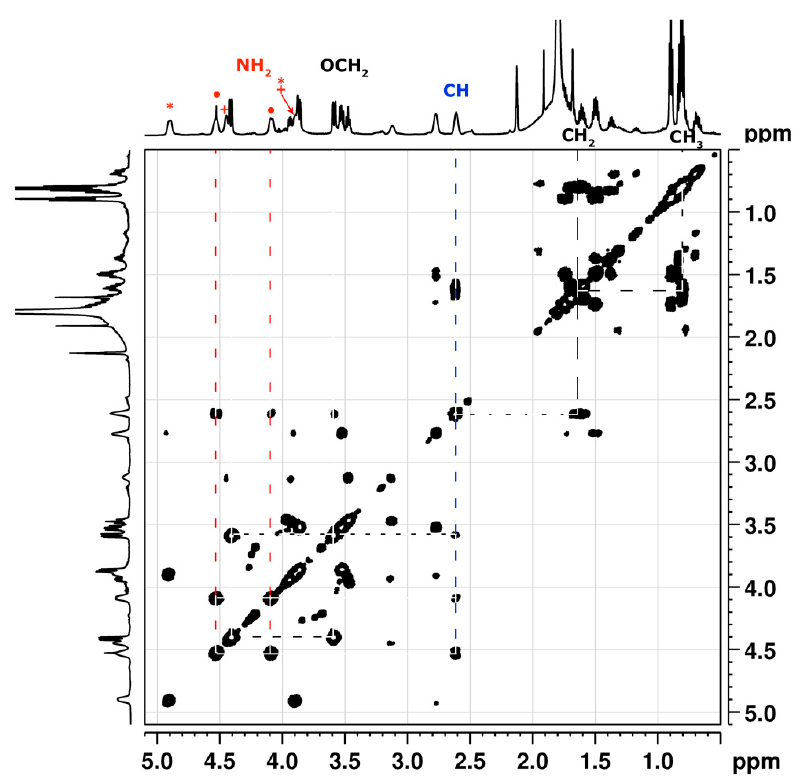
Figure 4. 1 H- 13 C HSQC NMR spectrum of 2 M mixture of ligand 2c and BH 3 •SMe 2 in toluene-d 8 . The correlation peaks originating from the three sets of 2-aminobutanol-based structural fragments are indicated as follows: ( a ) the OCH 2 groups (blue dots) and the CH(NH 2 ) groups (black dots), and ( b ) the CH 2 groups (blue dots) and CH 3 groups enclosed in the dashed rectangle. The six protons from the three NH 2 groups (red dots) were identified due to a lack of cross-peaks with C-atoms over one bond.